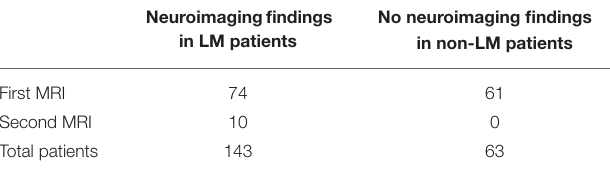
TABLE 3 | Diagnostic accuracy of magnetic resonance imaging (MRI).